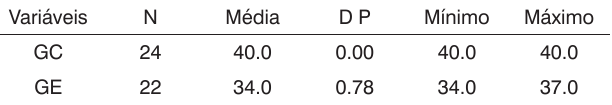
Tabela 4. Resultado do Teste de Figuras para Discriminação